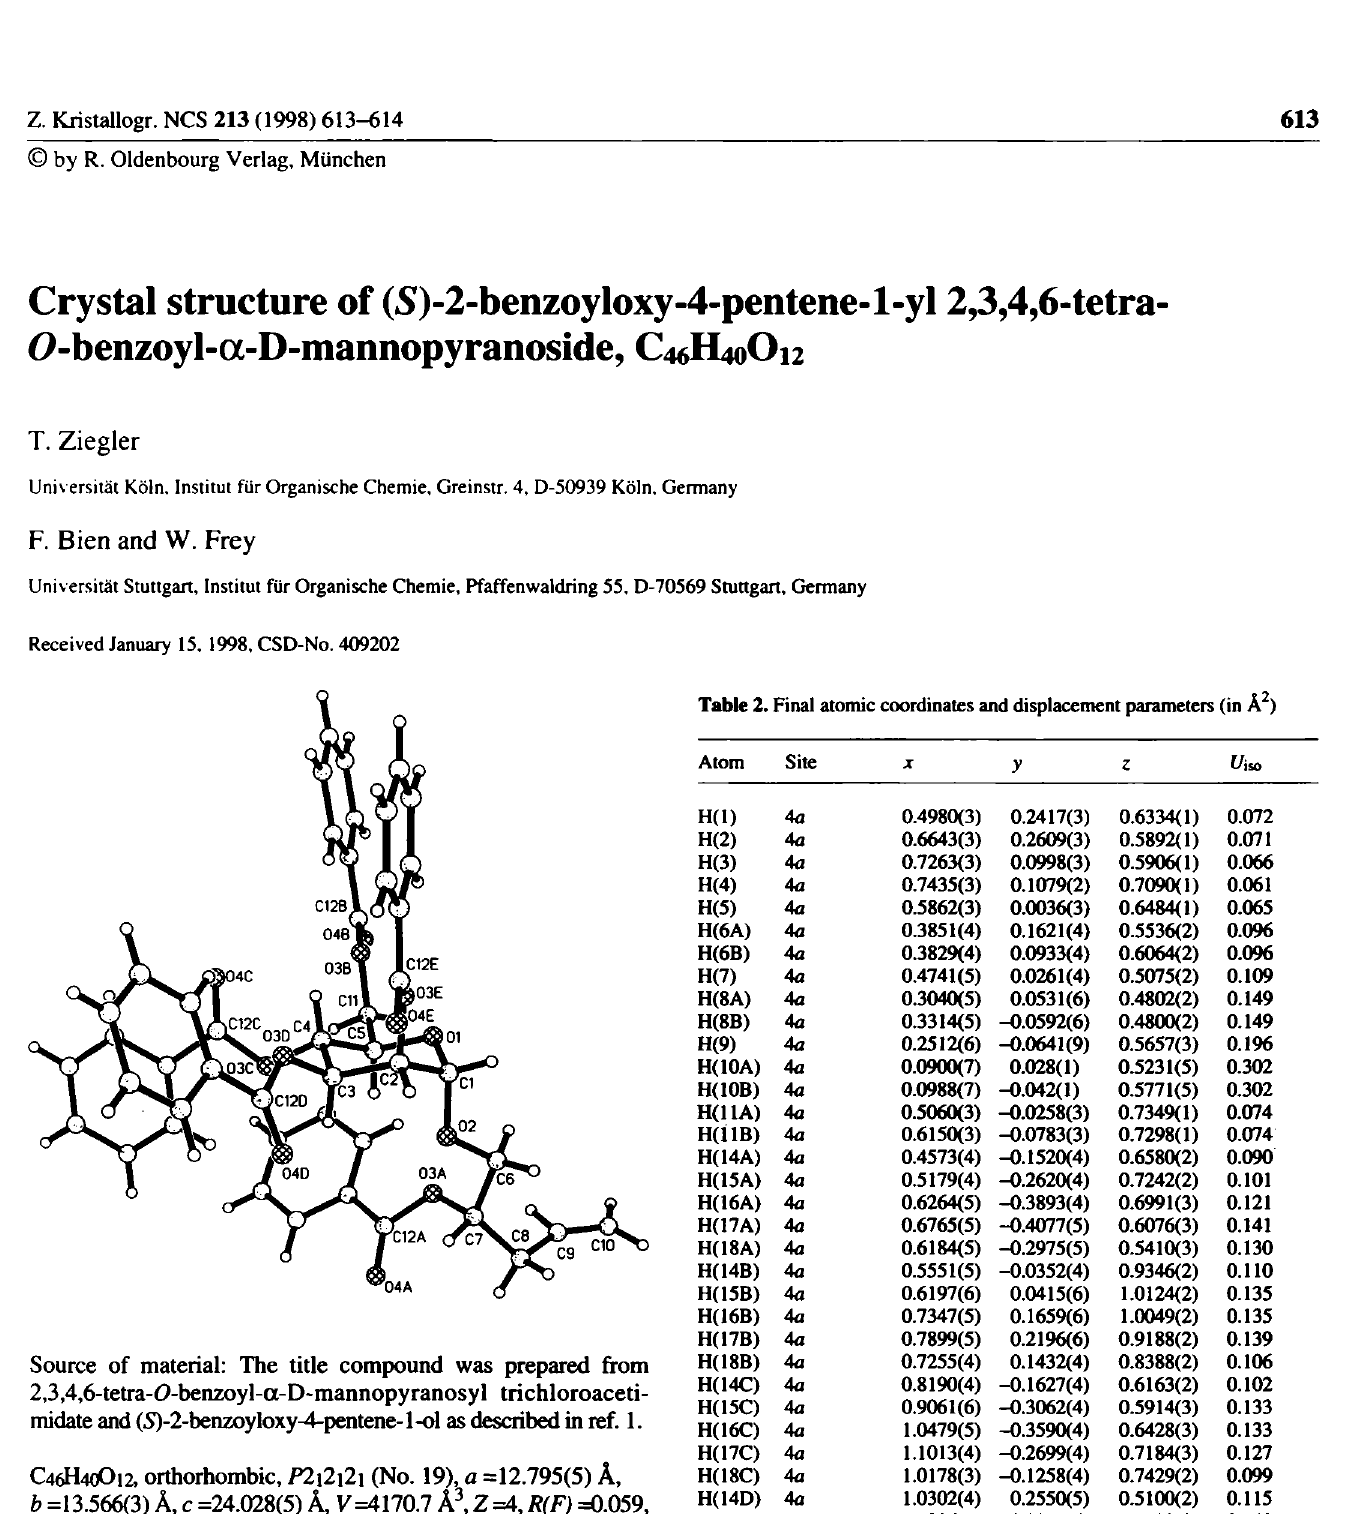
Table 1. Parameters used for the X-ray data collection